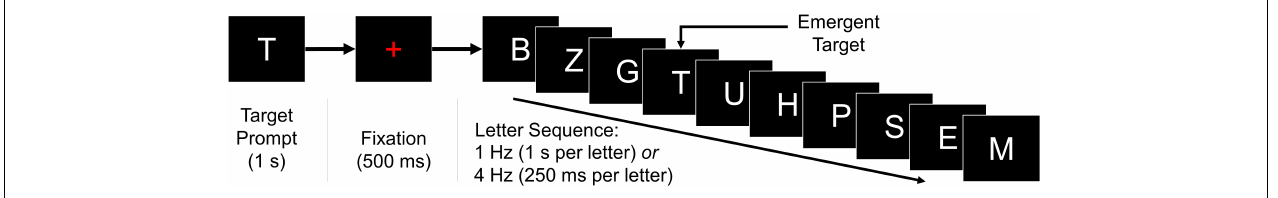
FIGURE 1 | RSVP calibration. Each instance of the RSVP calibration consisted of 100 ten-letter sequences, as illustrated. A target letter was presented on-screen for 1 s, followed by a red fixation cross for 500 ms, and then a random letter sequence containing the target. The 10-letter sequences were presented at a rate of either 1 or 4 Hz for the entirety of the task. A blank inter-stimulus interval of 750 ms separated the final letter of each sequence and the target prompt of the subsequent trial.